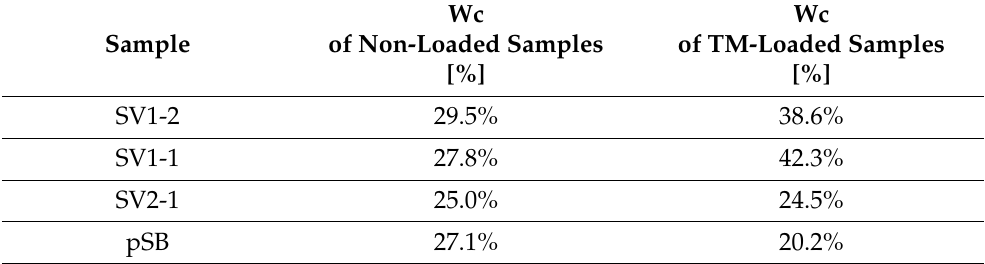
Table 3. Water content, Wc, in room-conditioned pSB-co-pVP networks, both non-drug-loaded and TM-loaded.